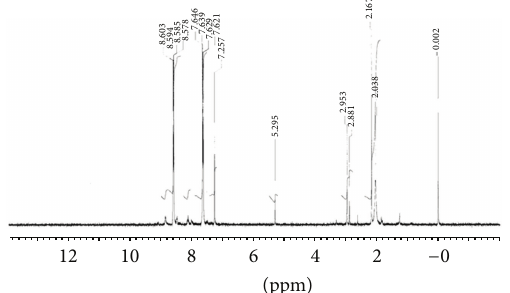
Figure 4: 1 H NMR spectrum of [Ru(L 1 ) 2 (NCS) 2 ]